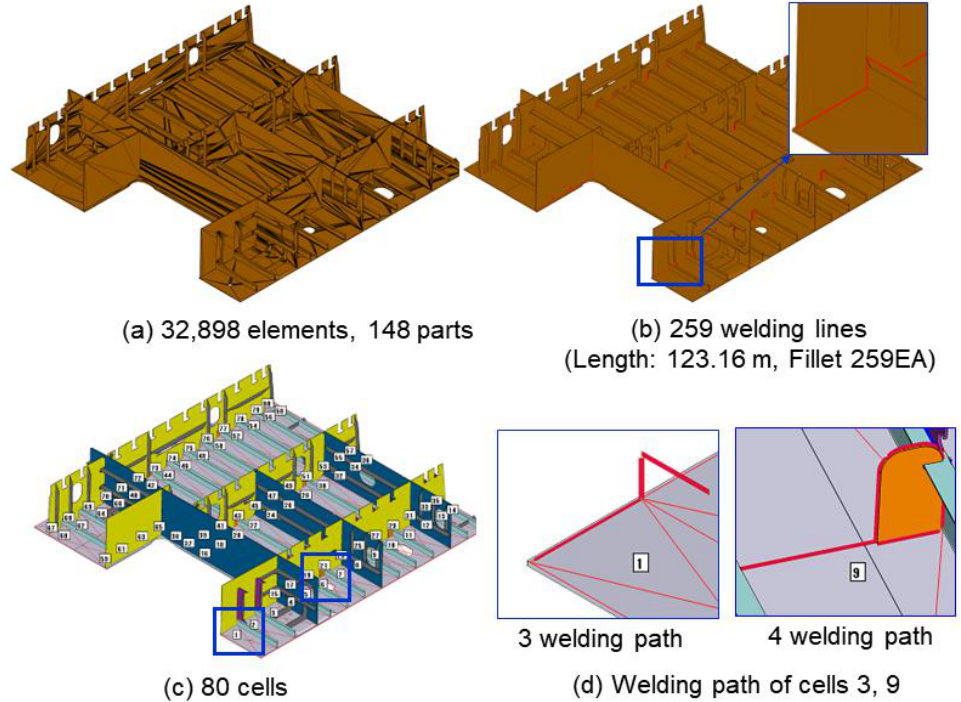
Figure 15. Welding path generation from a structural block.